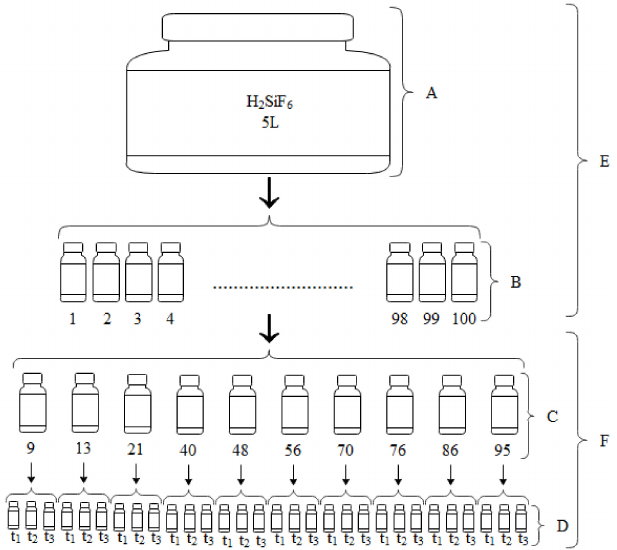
Figure 1. Scheme of the homogeneity study. (A) batch of fluosilicic acid; (B) sampling; (C) stratified samples contributing to the between-bottle variation; (D) aliquots contributing to within-bottle variation; (E) preparation; (F)